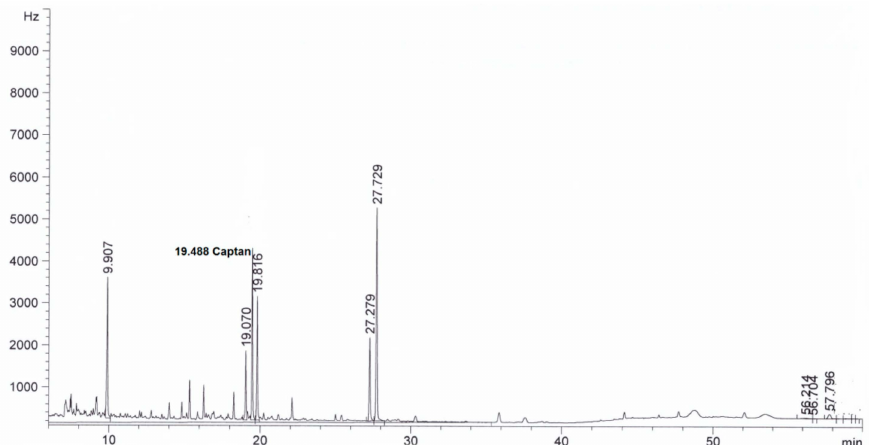
Figure 5. The chromatogram (GC- µ ECD) of industrial wastewater with the clean-up step using the dSPE [0.15 g primary and secondary amine (PSA)].